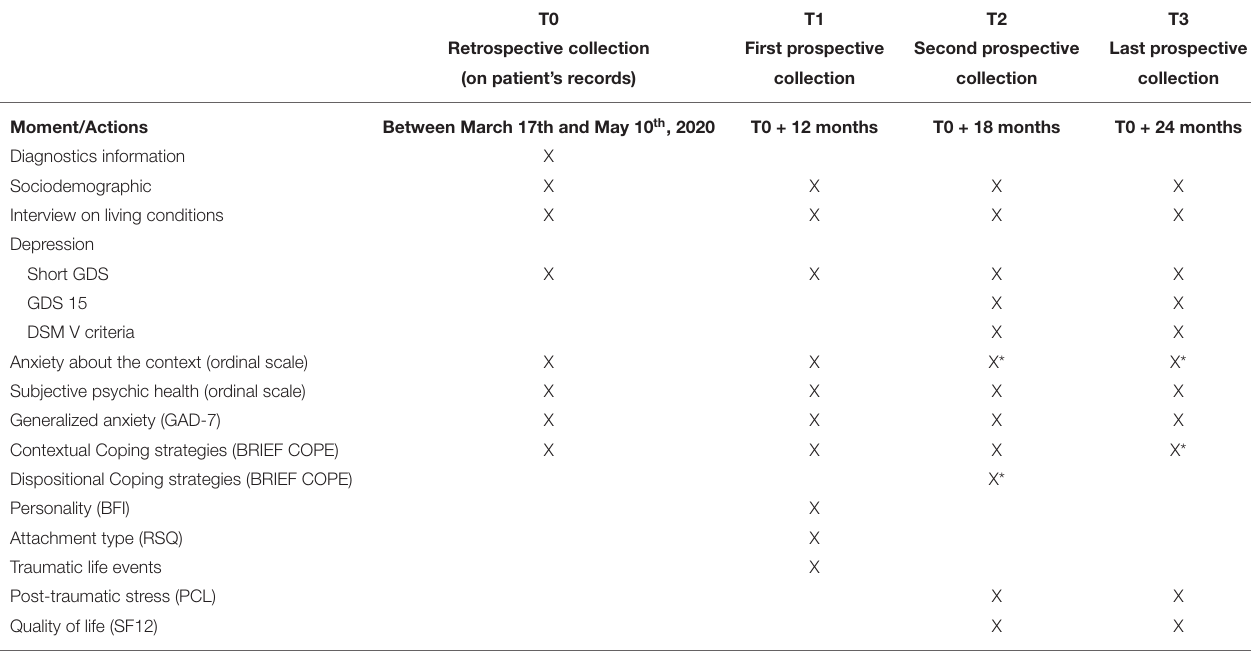
TABLE A | Summary of follow-up data